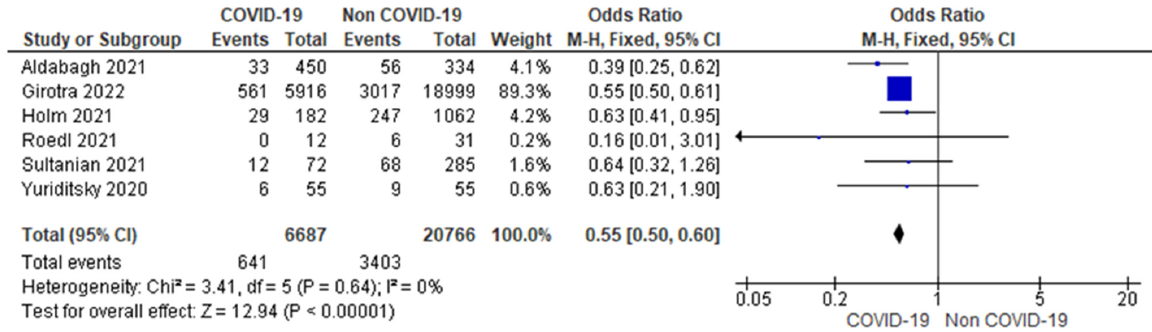
Figure 2. Forest plot showing group difference for shockable rhythm among COVID-19 versus non-COVID-19 patients using fixed effect. [12–17].